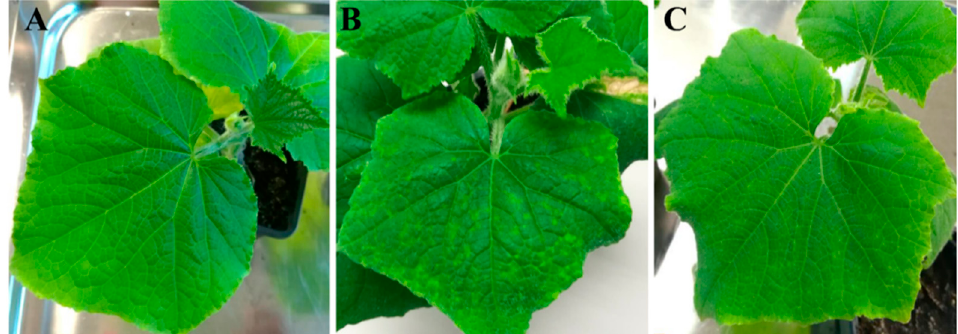
Figure 3. ( A ) Asymptomatic plant of the resistant accession CGN23089 30 days after mechanical inoculation (dpi) with ToLCNDV. ( B ) Symptomatic plant of the susceptible accession BGV011742. ( C ) Symptoms in an F 1 plant of the cross CGN23089 x BGV011742 at 30 dpi.